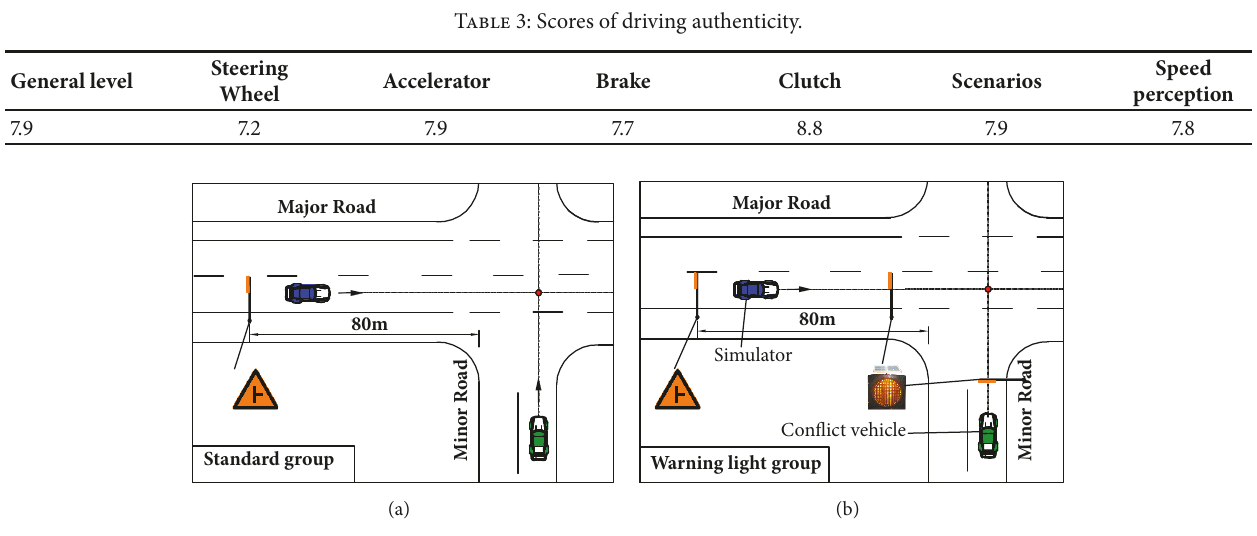
Figure 4: Description of the two scenarios: (a) standard group; (b) warning light